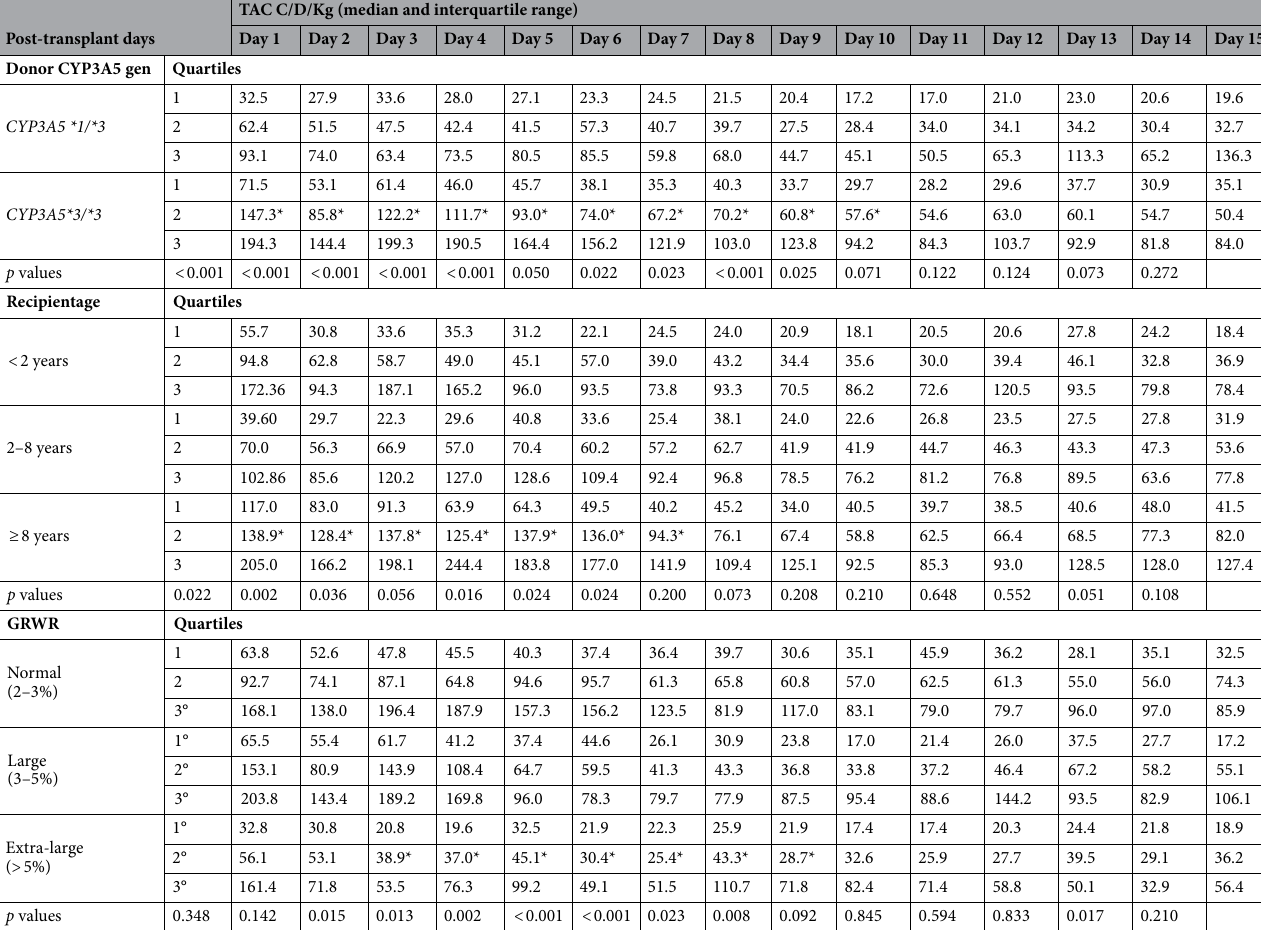
Table 2. TAC concentration/weight-adjusted dose ratio (C/D/Kg) in the first 15 days from transplantation stratified by donor CYP3A5 genotype, recipient age and GRWR. Asterisks (*) indicate statistically significant differences between the marked group and the